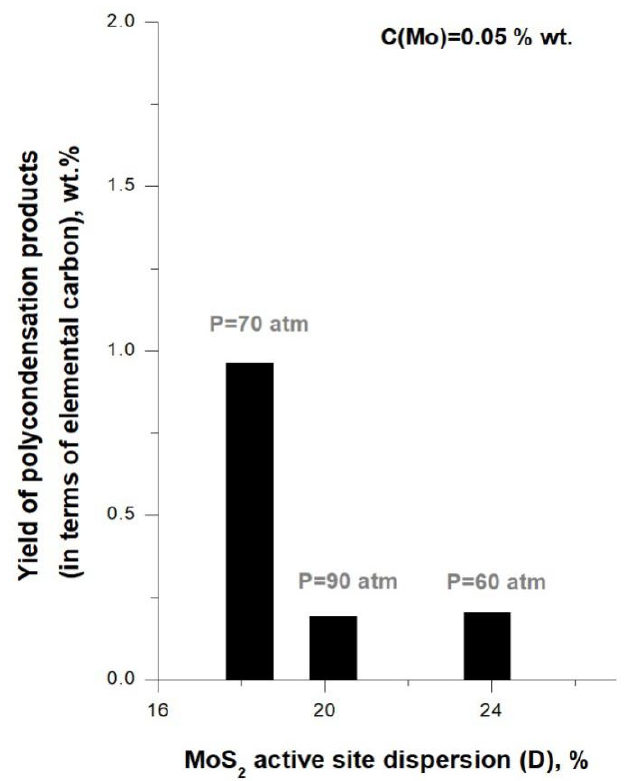
Figure 6. Correlation between the yield of polycondensation products and catalyst active site dispersion) in pressure variation tests.